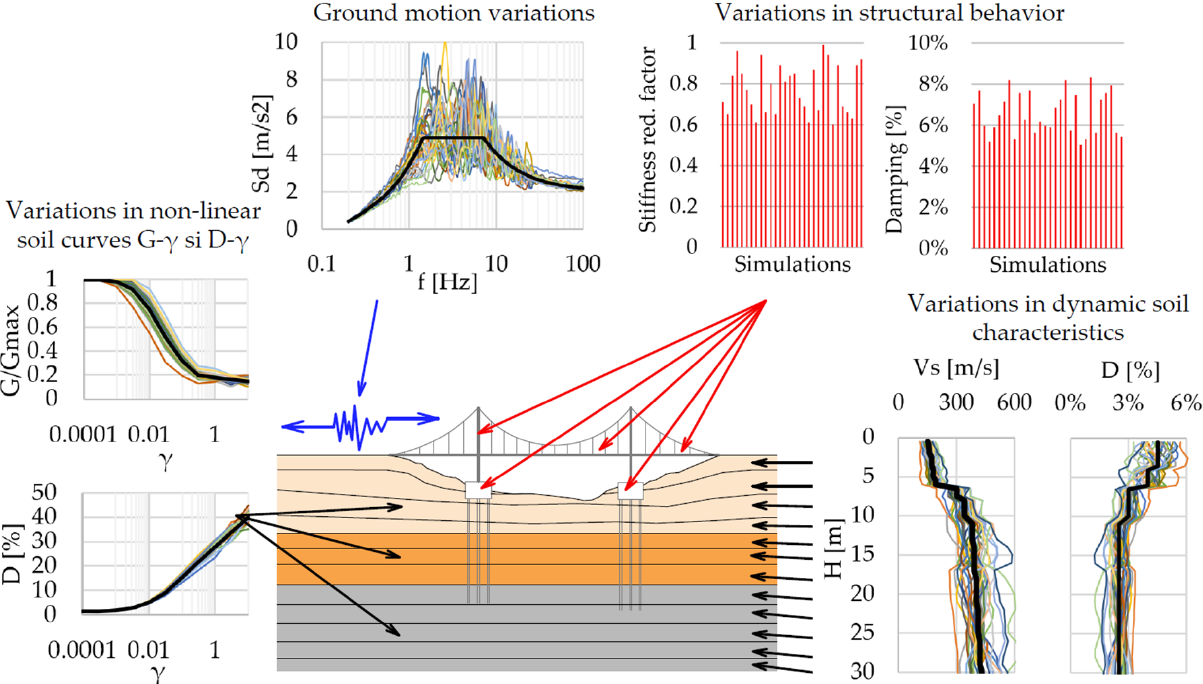
Figure 1. Overview of a complete probabilistic SSI analysis.